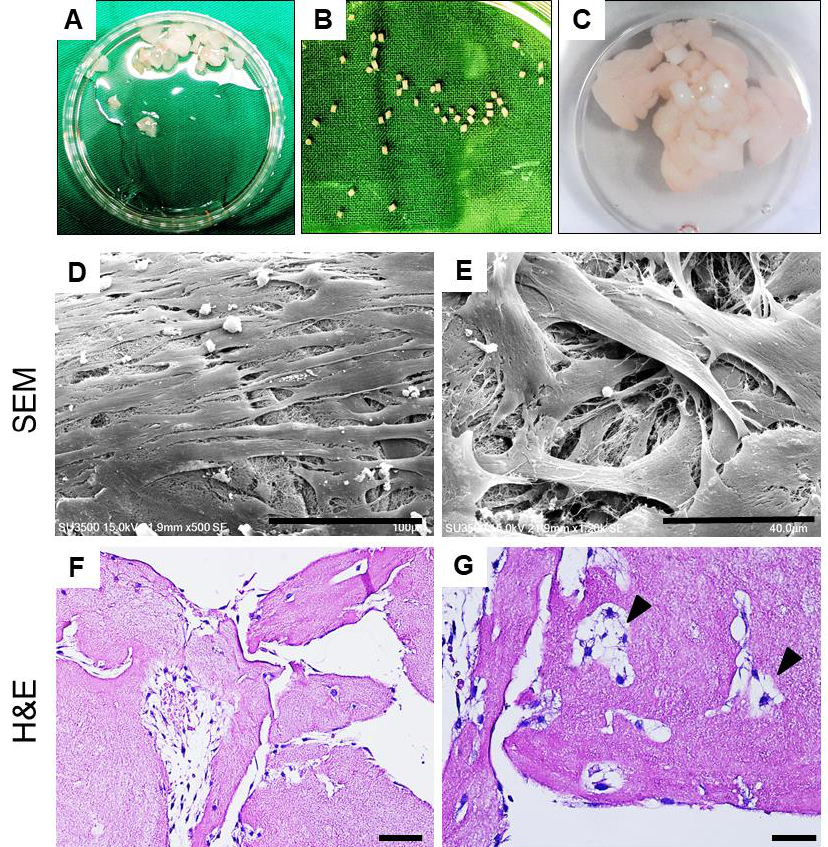
Figure 3. ( A – C ) Illustration of PRF-cartilage graft co-culture model: ( A ) Diced platelet-rich fibrin, ( B ) cartilage grafts harvested from porcine joint, and ( C ) co-culture of platelet-rich fibrin and cartilage grafts. ( D and E ) Scanning electron microscopy (SEM) observation of the PRF scaffold after 10 days of culture. The SEM images showed chondrocytes attachment and growth on PRF from low to high magnifications. ( F and G ) Hematoxylin and eosin ( H & E ) of histological sections of PRF scaffold on day 10 showed the chondrocyte migration and growth on porous structures. At magnified view, chondrocytes were in cluster and presented with lacunae-like structures (arrowheads). Scale bars: 100 μm ( D ), 40 μm ( E ), 50 μm ( F ), and 25 μm ( G ).